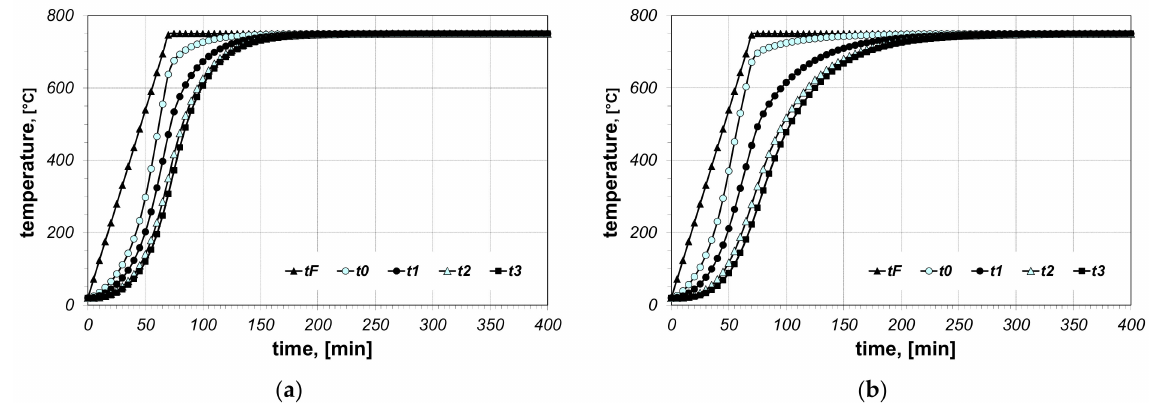
Figure 7. Calculated values of temperatures for heating of a 5 × 20 bar bundle with mixed arrangement: ( a ) results obtained for R ct-min , ( b ) results obtained for R ct-max .